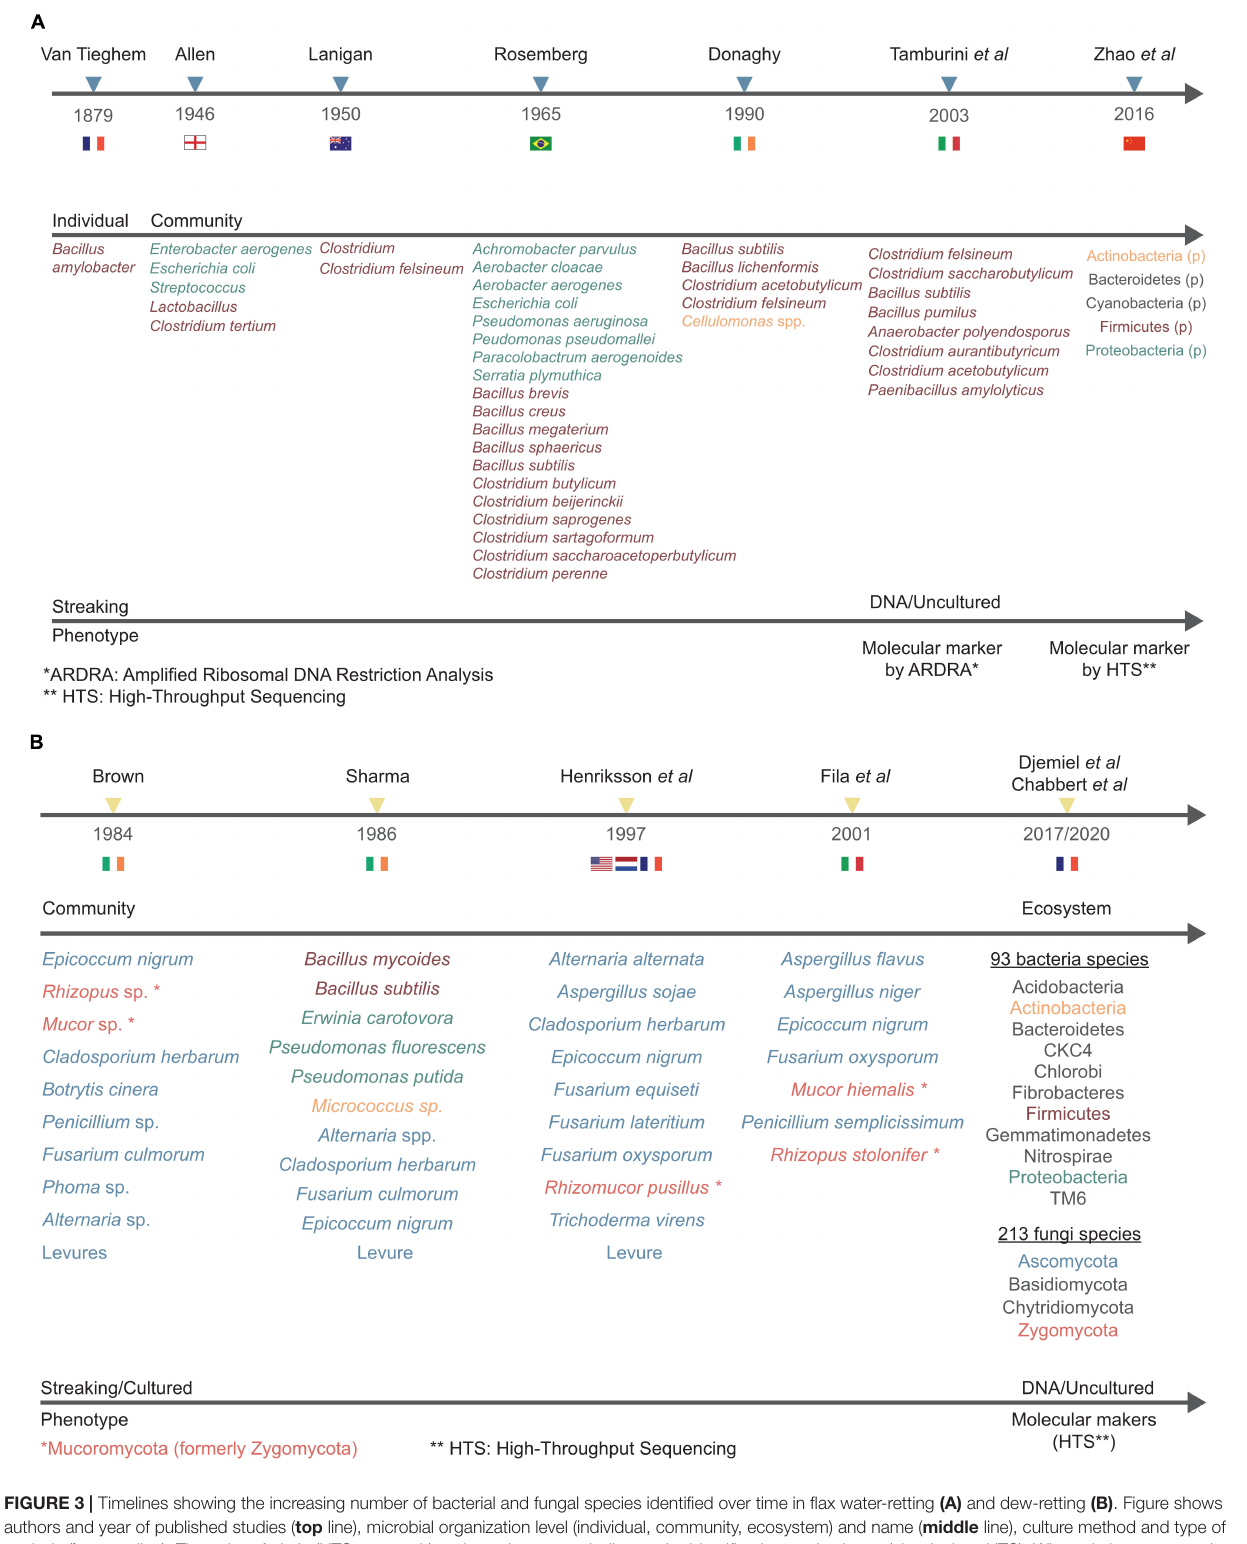
Frontiers in Genetics |